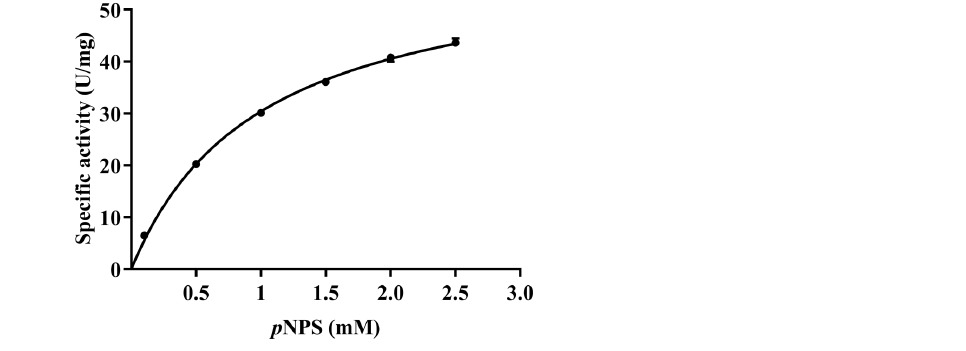
Figure 3. Specific activity of PaAst towards p NPS. Some error bars could not be seen. Table 1. Purification yields of recombinant PaAst.